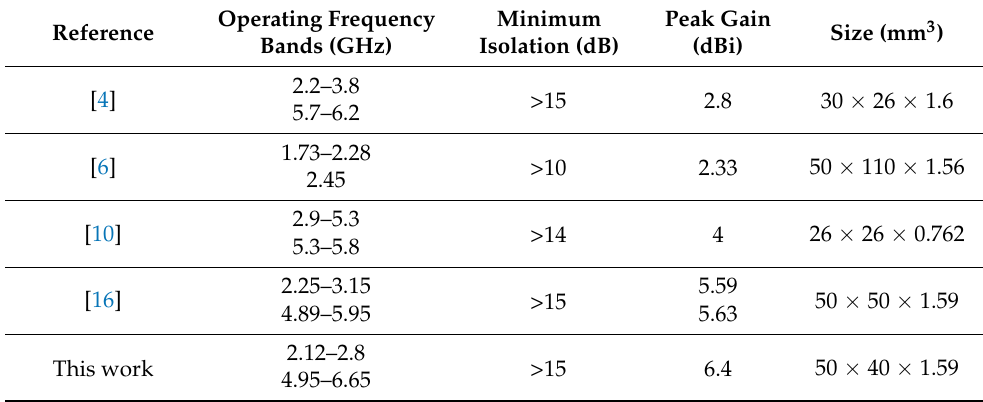
Table 3. Performance comparison with recently published